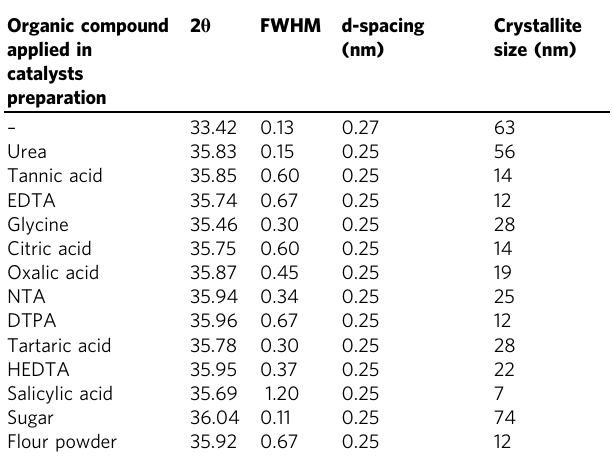
Table 5 Crystallite size of catalysts prepared with different organic compounds. Organic compound applied in catalysts preparation